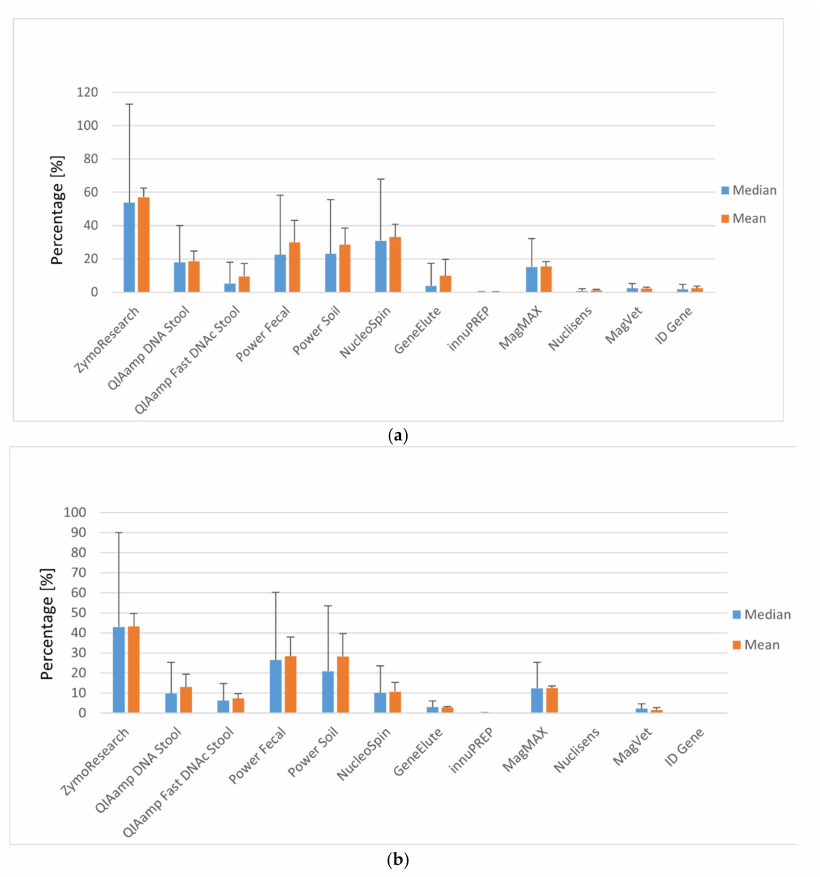
Figure 2. ( a ) E ffi ciency of MAP DNA isolation in faecal pellets using selected isolation kits: ZR Quick-DNA Fecal Soil Microbe Microprep Kit (Zymo Research, Tustin, CA, USA),